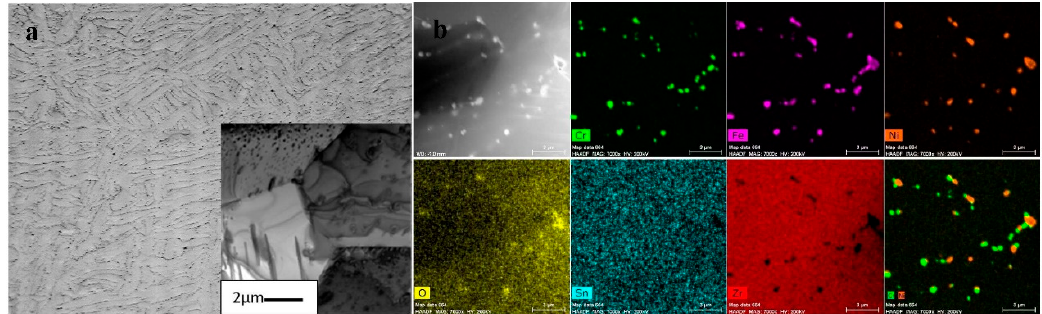
Figure 1. ( a ) Optical micrograph on Zircaloy-2, showing elongated grains. Inset shows the transmission electron microscopy (TEM) bright field micrograph of the grain structure. ( b ) Low magnification scanning transmission electron microscopy associated with energy-dispersive X-ray spectroscopy STEM-EDS mapping on Zircaloy-2 showing the distribution of intermetallic precipitates. The scale bar of those maps is 3 µm. The brightness of colors in element map indicates their concentration. The higher concentration shows in brighter contrast, and the darker area means depletion of this element.